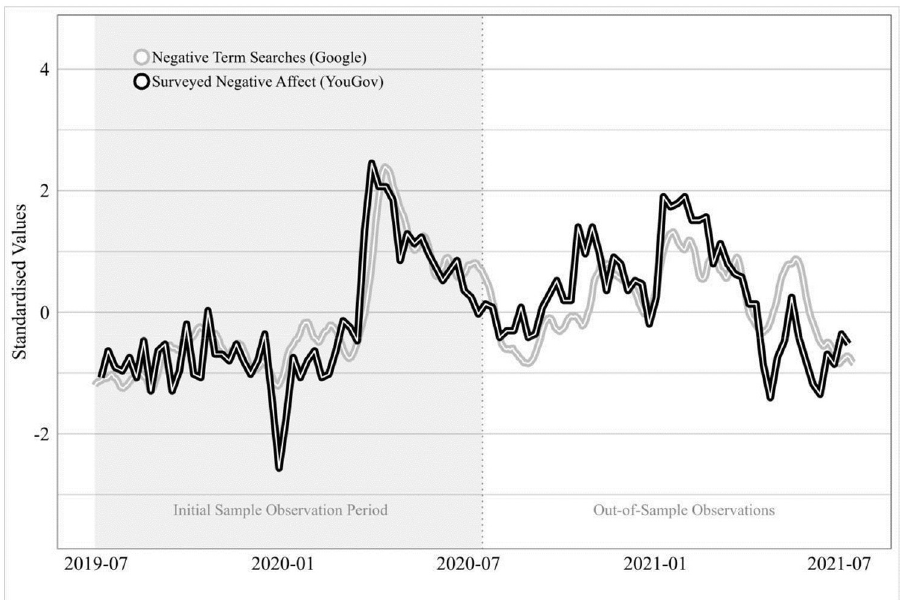
Fig 3. Comparison of survey and Google trend series, June 2019 to June 2020. The shaded (left) portion of the chart shows the correlation between negative affect mentions in the YouGov survey versus the negative affect search index based on Google data, at the time of the index construction (June 2020). The unshaded (right) portion of the chart shows how the YouGov weekly survey data and the Google search index have continued to covary in sync with one another during the subsequent year. The Negative Affect Index is based on YouGov weekly polling data, for a representative sample of circa 2,000 respondents across England, Scotland and Wales (216,441 total). It comprises the sum of all negative affect states reported by respondents. The Negative Affect Search Index is based on Google Trends data for the United Kingdom, and includes corresponding matches for stress (‘psychological stress’), boredom, sadness, feeling scared (‘fear’) and apathy, weighted by their R 2 correlation with their individual matching terms. A two-week smoothing function has been applied to the weekly data for both measures. Indexes standardised (mean 0, standard deviation 1) for comparison